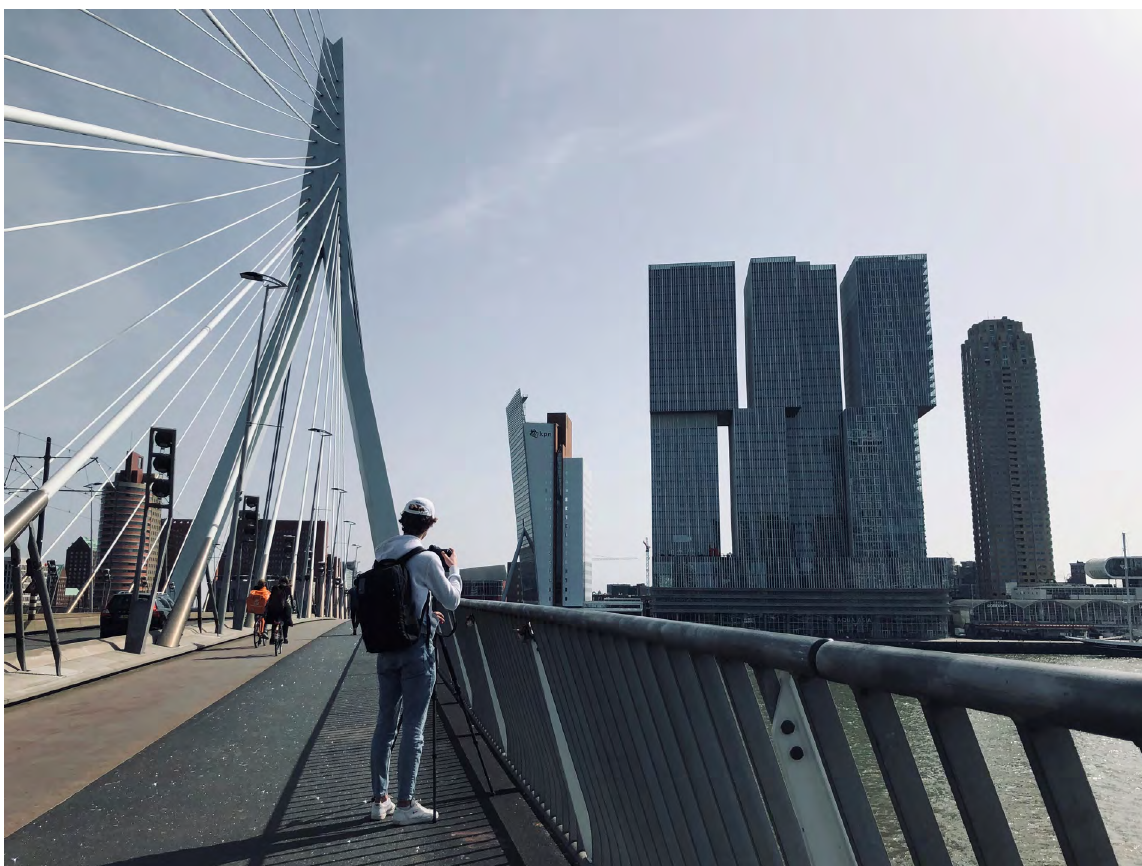
FIG. 2 Tourist taking a Photo of the Kop van Zuid from the Erasmus Bridge, 2021, cred- its by Maurice